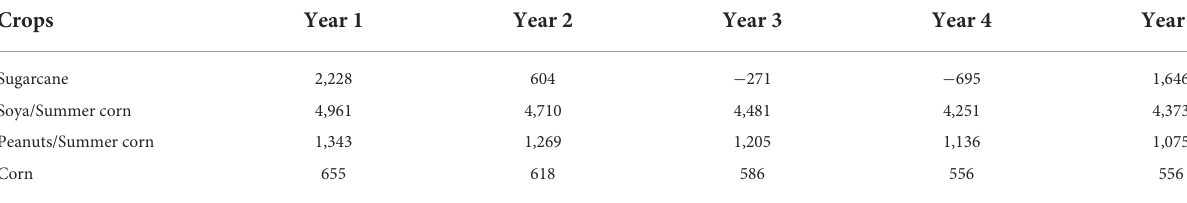
TABLE 9 Mean discounted contribution margin calculated in R$ per hectare.